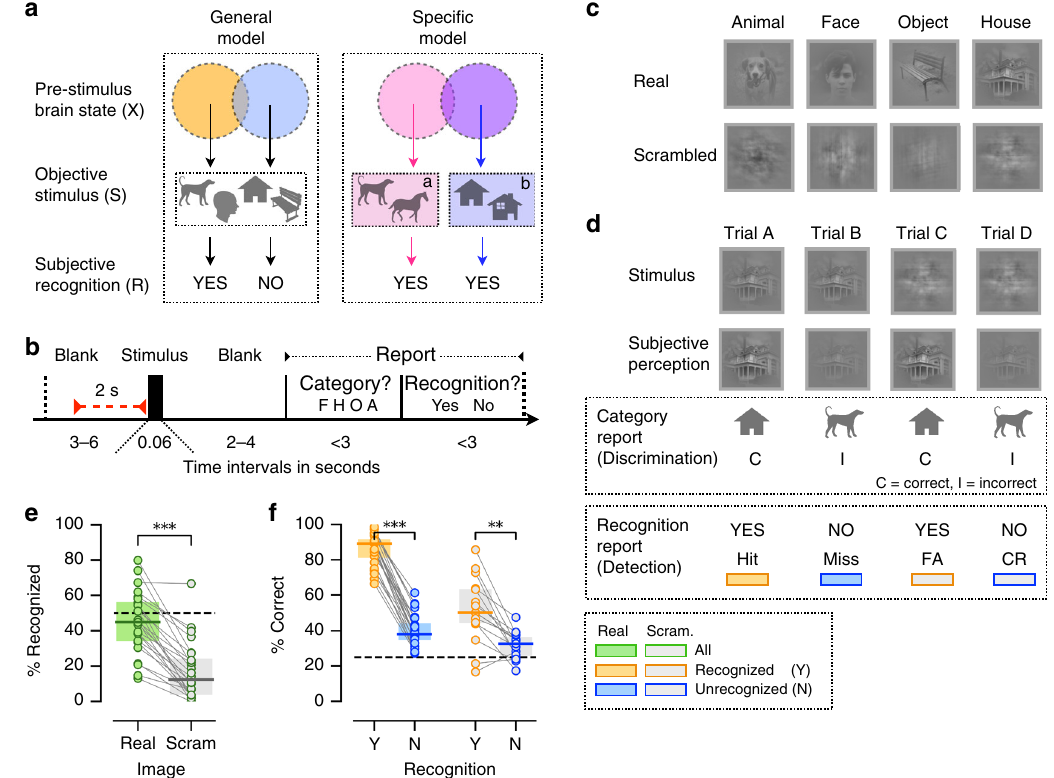
Fig. 1 Hypothesis, experimental paradigm and behavioral results. a Hypothesis illustration. General model: The stimulus (S) has a preferred pre-stimulus brain state (orange) that increases the probability of recognition experience (R = yes), regardless of objective stimulus category. Speci fi c model: Pre- stimulus brain states facilitate recognition in a category-speci fi c manner: the optimal brain state for recognizing a stimulus from category a differs from the optimal state for recognizing a stimulus from category b . b Paradigm timeline. Each trial began with a fi xation cross presented on a blank screen. Next, a brief stimulus was presented at a contrast determined by the participant ’ s individual recognition threshold. Subjects were asked to report the stimulus category and their recognition experience. Neural activity recorded in a 2-s window prior to stimulus onset was used in neural data analyses (red bar). F/H/O/A correspond to Face/House/Object/Animal. c Example real and scrambled images from each stimulus category. d Illustration of trial types. For each subject, identical real and scrambled stimuli (top) may be reported as recognized on one trial and not recognized on another. When real stimulus is reported as recognized, it is considered a “ Hit ” because it contains an object (bottom). The accuracy of category discrimination in scrambled-image trials is determined based on the original stimulus category used to generate the scrambled image e Percentage of trials reported as recognized for real and scrambled images. Dashed line indicates intended threshold-level recognition rate for real images (Wilcoxon signed-rank test). f Accuracy of category report in recognized and unrecognized trials of real ( N = 24) and scrambled images (Wilcoxon signed-rank test, N = 15, only subjects reporting more than fi ve scrambled-image trials as recognized are included). In all fi gures, boxplot center line depicts the median and edges indicate the quartiles; * p <